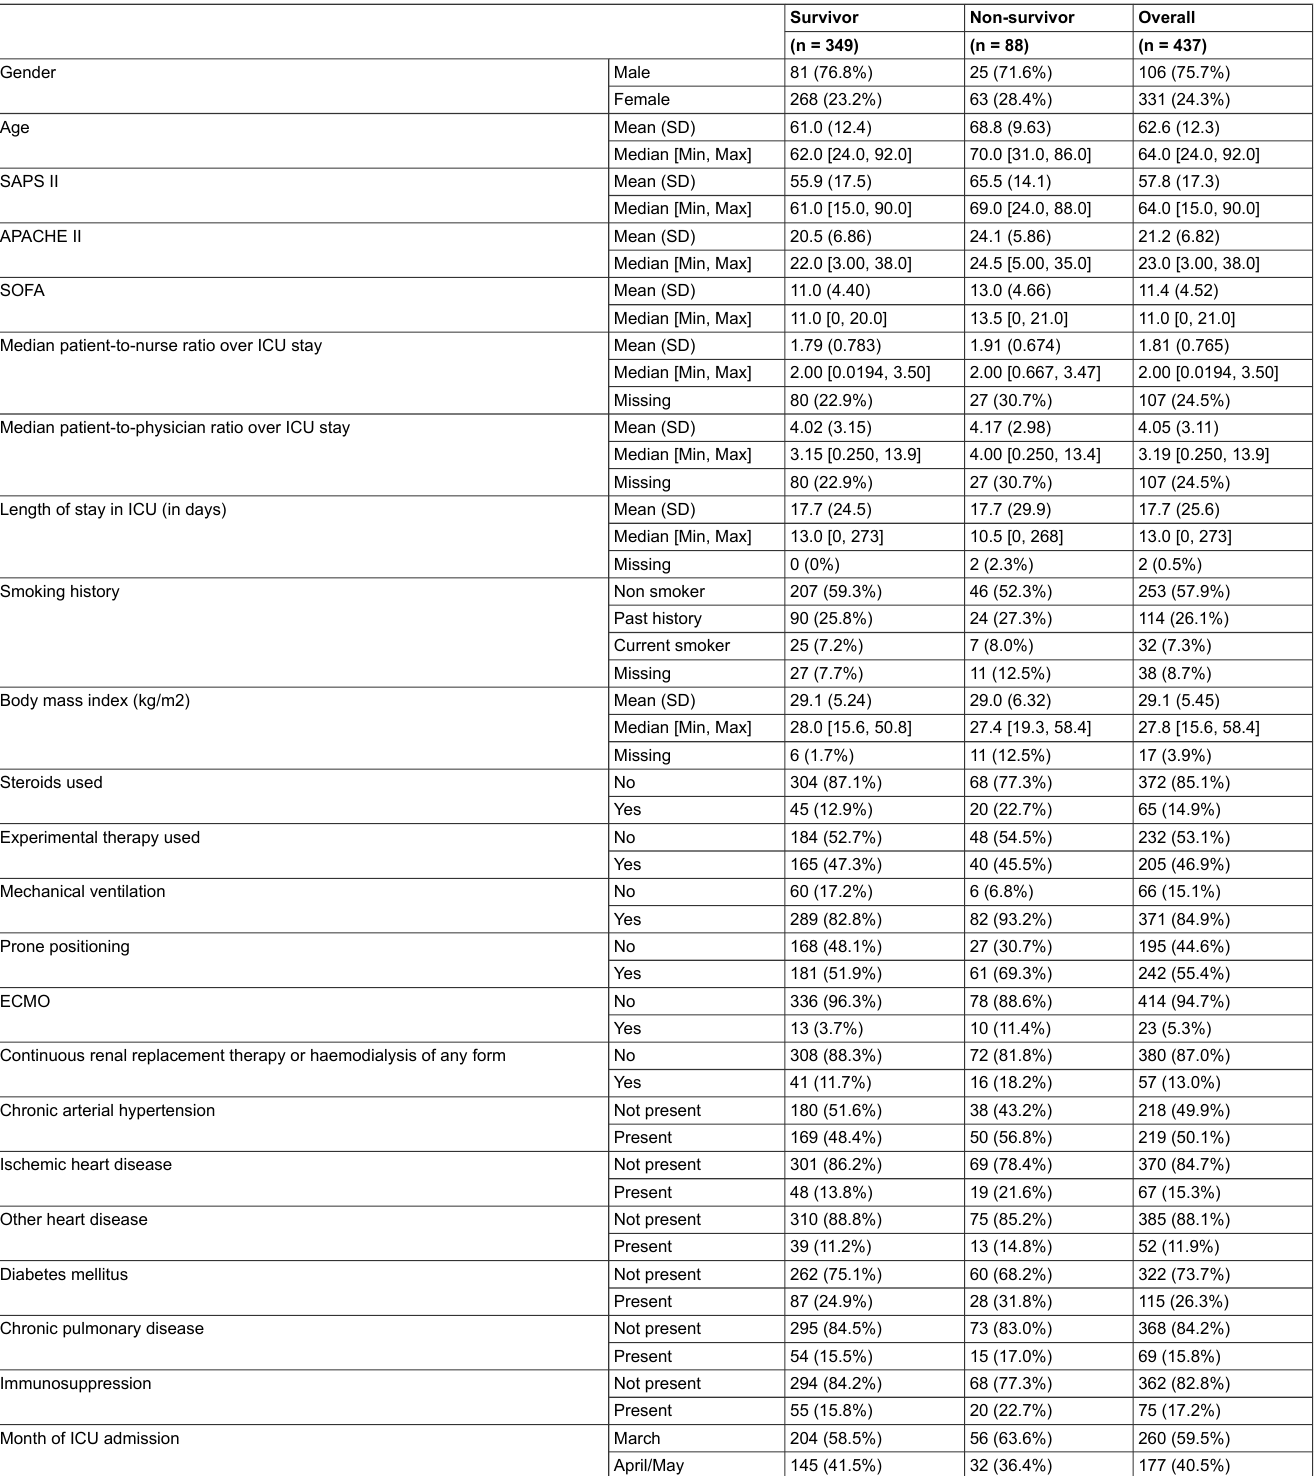
Table S1: Patient characteristics and outcomes, by surviving